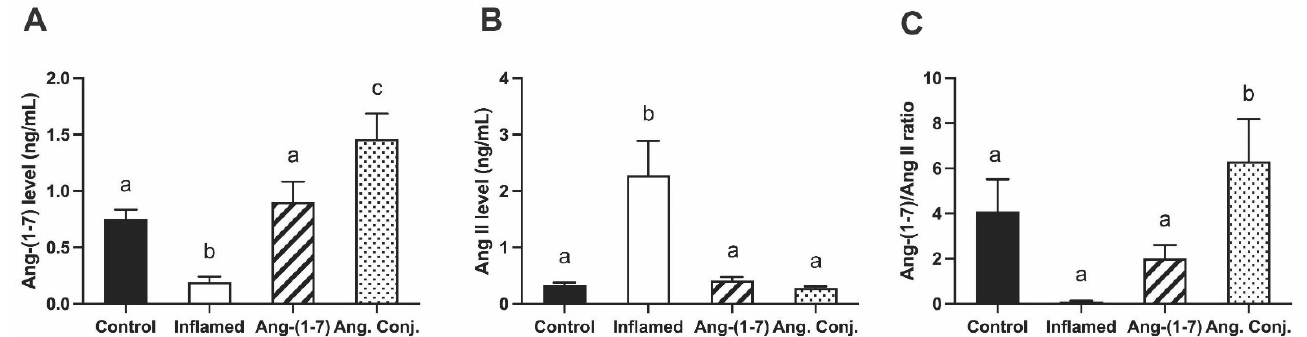
Figure 4. The plasma concentration of Ang-(1-7) ( A ), Ang II ( B ), and their ratio ( C ) in control ( n = 6), inflamed ( n = 6), Ang-(1-7)-treated ( n = 5), and Ang. Conj.-treated ( n = 5) groups. The values are reported as mean ± SEM, and statistical analysis was done using one-way ANOVA with the Tukey multiple comparison post-hoc test. Groups labeled with different letters have significant differences between them ( p < 0.05).